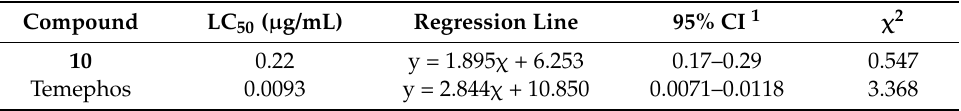
Table 2. LC 50 values of compound 10 against Ae. albopictus